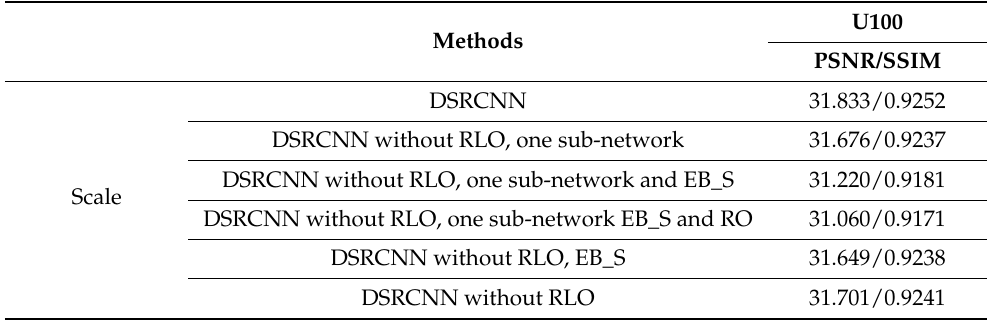
Figure 3. Visual figures of different methods. Table 1. PSNR and SSIM of different methods on U100 for